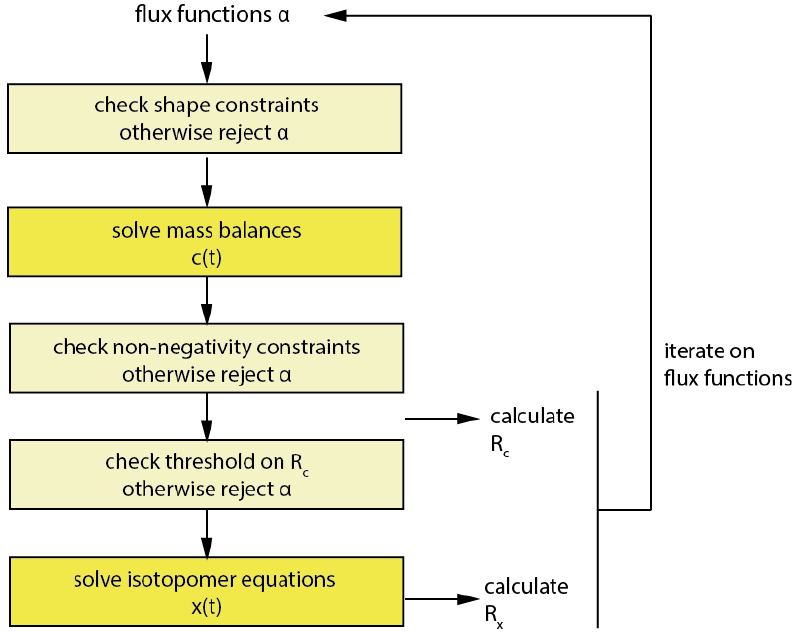
Figure 7. Workflow of the optimization in imfil